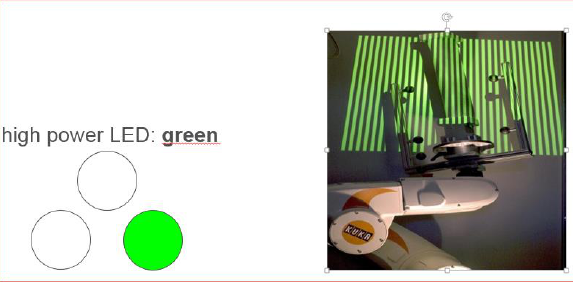
Figure 12b: Multi color projection -red